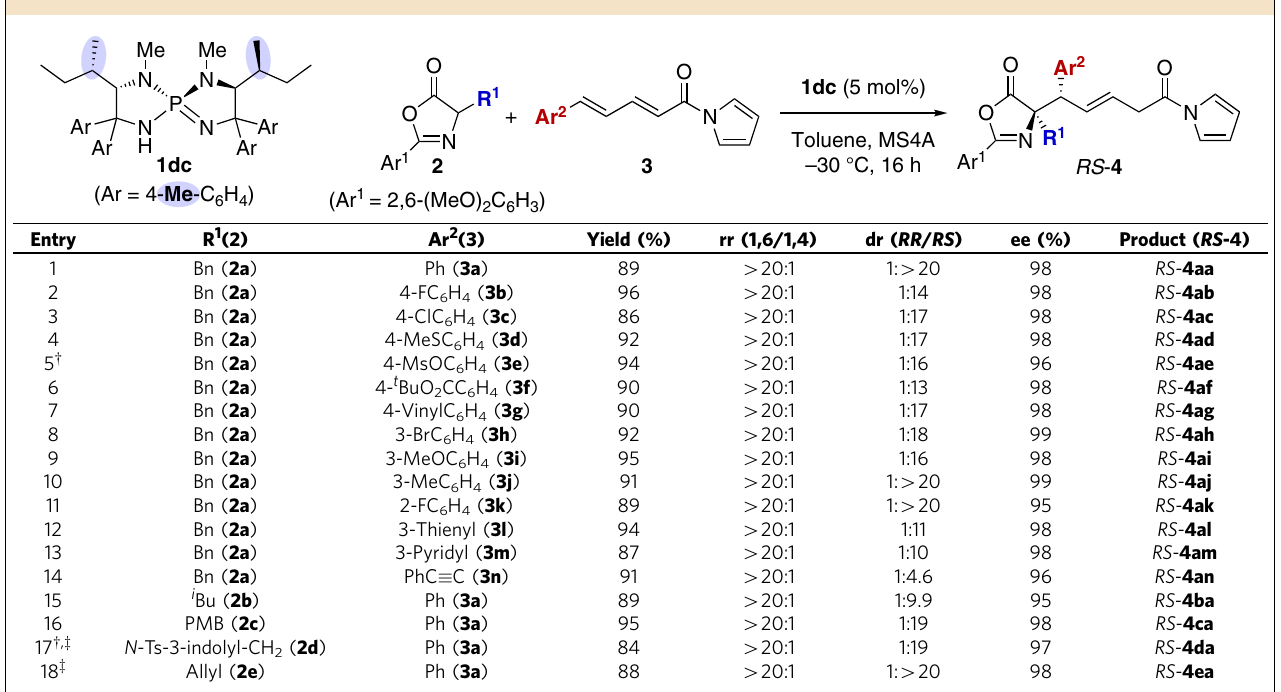
Table 3 | Substrate scope for 1dc-catalysed 1,6-addition to d -aryl dienyl N -acylpyrroles 3*.